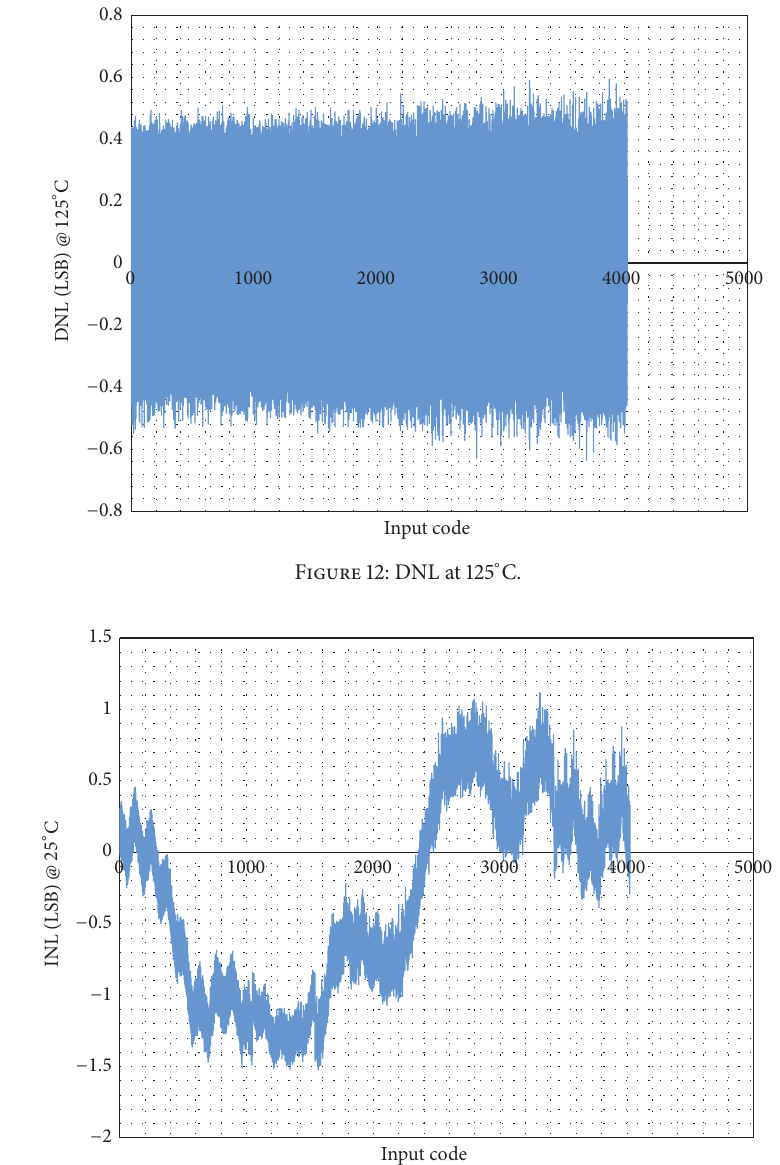
Figure 13: INL at 25 ∘